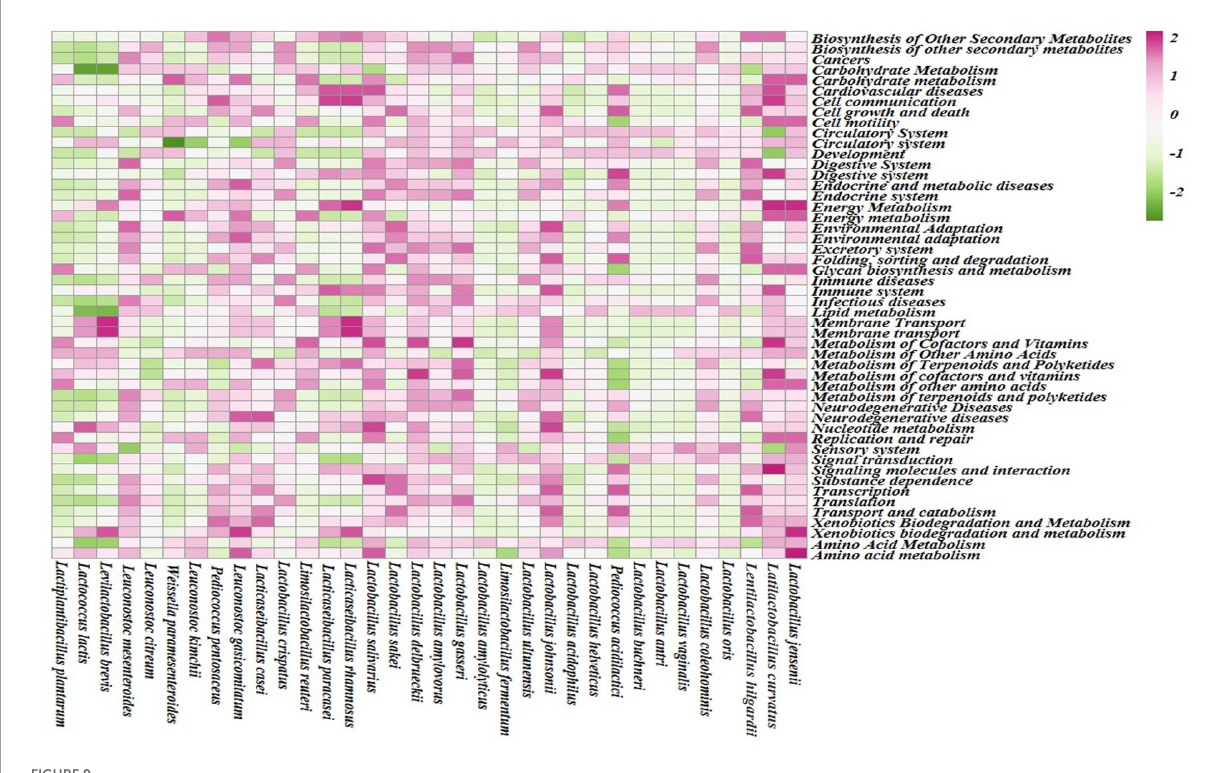
FIGURE9 Spearman RS correlation of major bacterial species with KEGG (level 2)